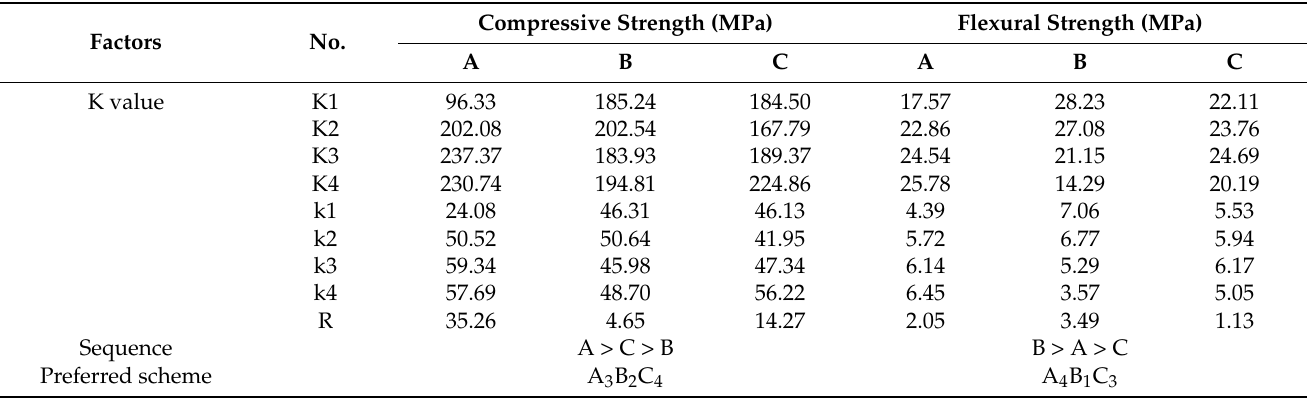
Table 7. Analysis results of the polar differences in the mechanical properties of the K-based geopoly- mers at 7 days.